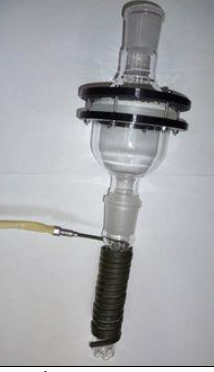
Fig. 19. The HGBIK